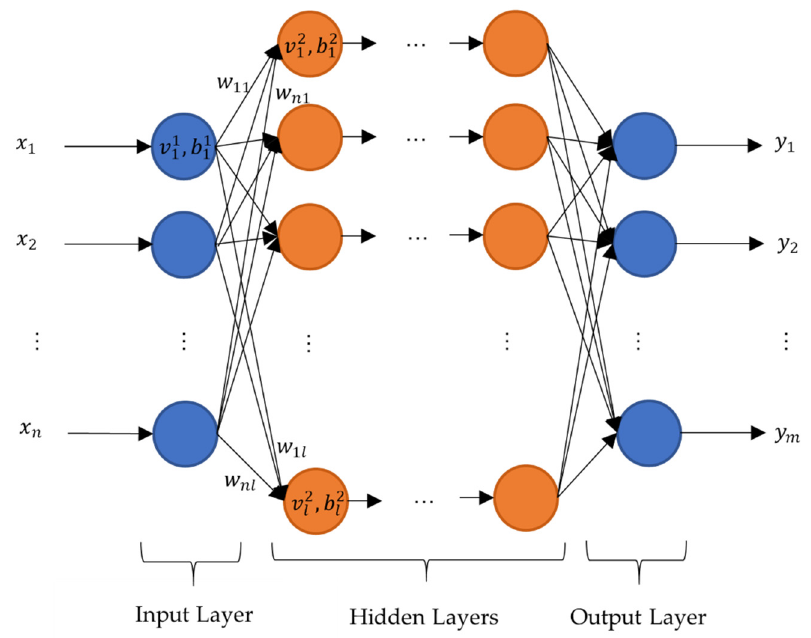
Figure 4. Schematic design of neural network with dense layers.